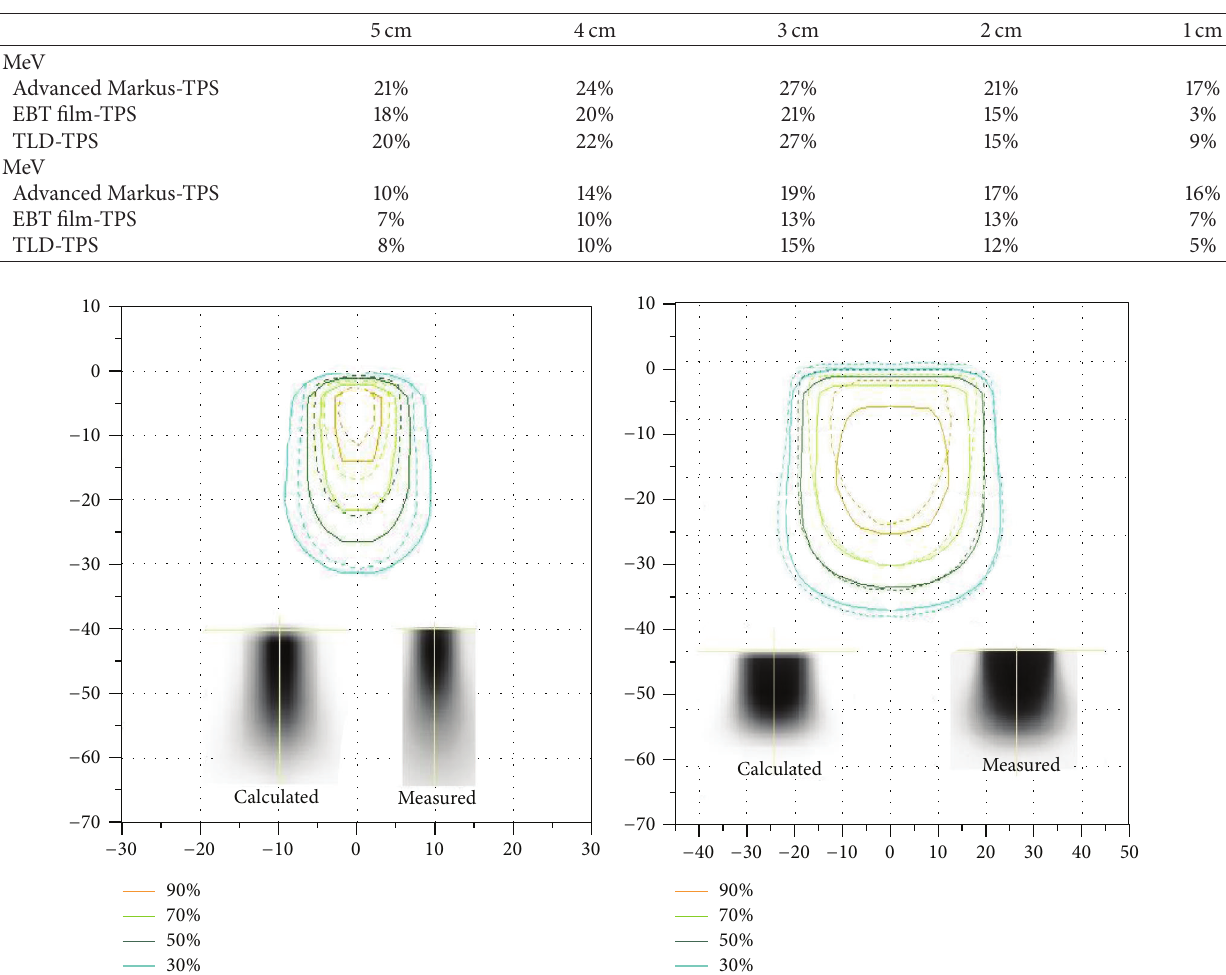
Table 2: Percentage differences between calculated and measured outputs from different measurement methods at 6 and 9MeV nominal energies for 5, 4, 3, 2, and 1 cm field sizes. For both energies, 10 × 10 cm 2 field size was assumed for TPS values.